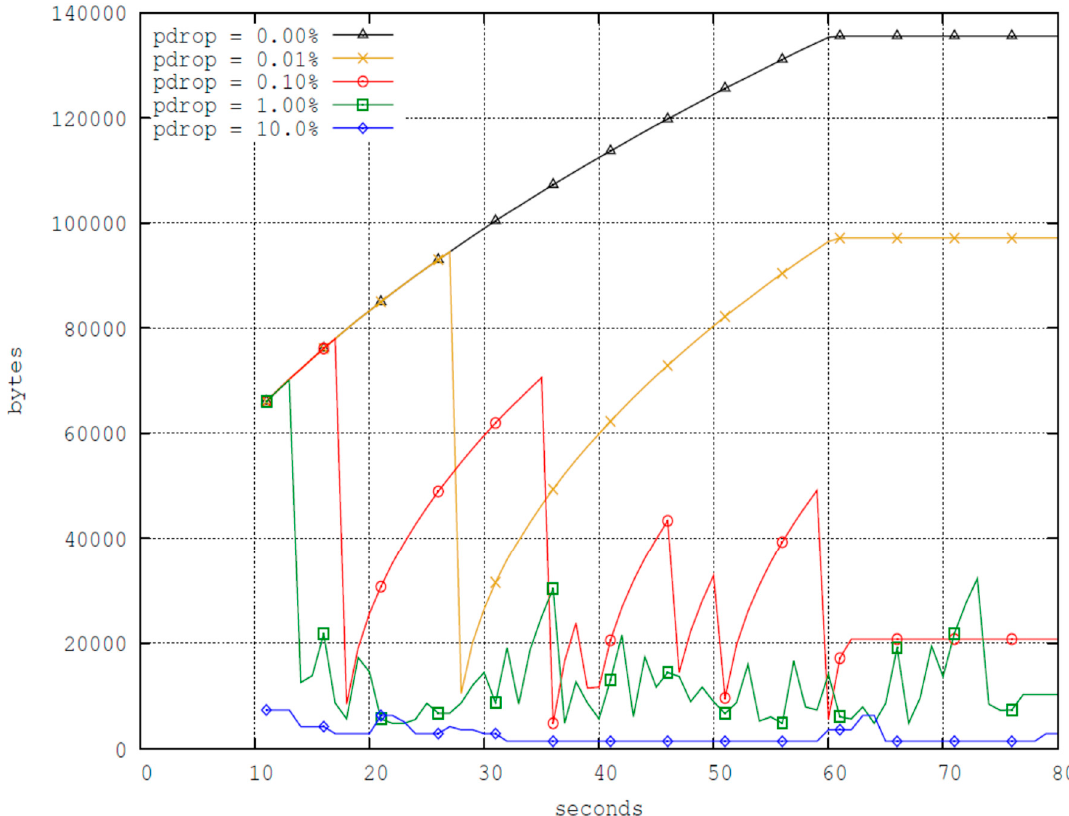
Figure 3. Effect of TCP Congestion Window Size on Packet Dropping (first 80 s).